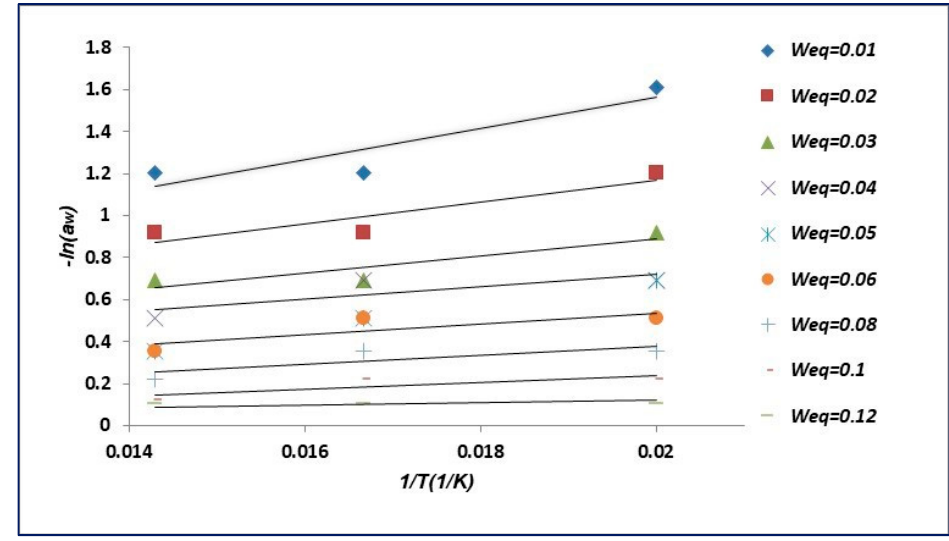
Figure 11. Desorption isosters of corn kernel. The net isosteric heat of desorption for each equilibrium moisture content is shown in Figure 12.